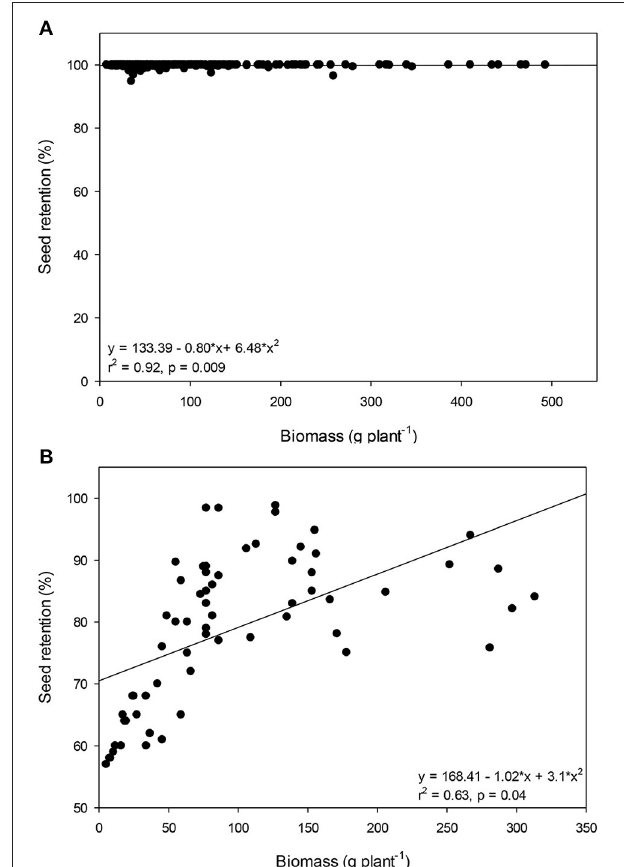
FIGURE 2 | Mean percent seed retention for (A) Amaranthus palmeri and (B) Echinochloa crus-galli by biomass (g plant − 1 ). Data pooled across years and